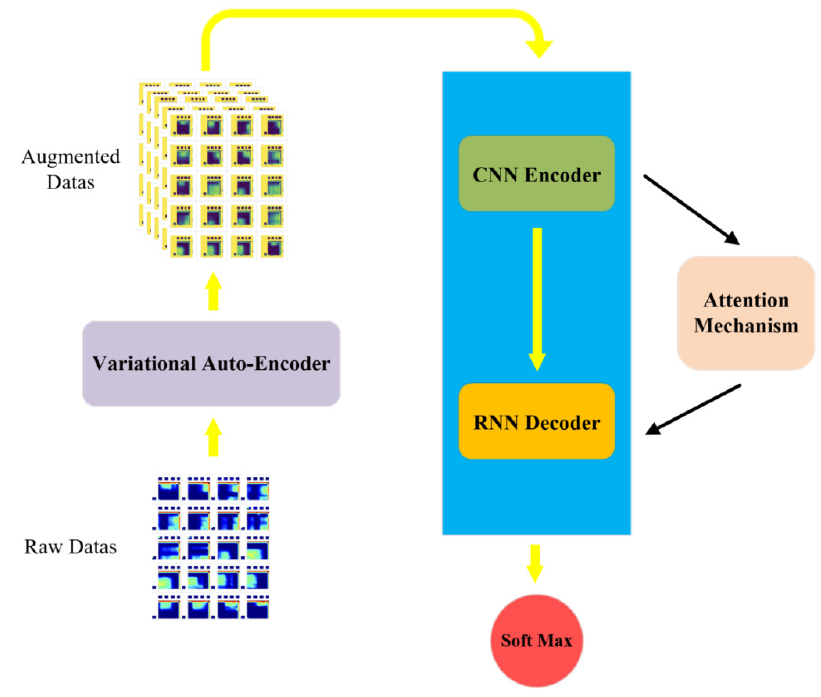
Figure 6. Network structure diagram.